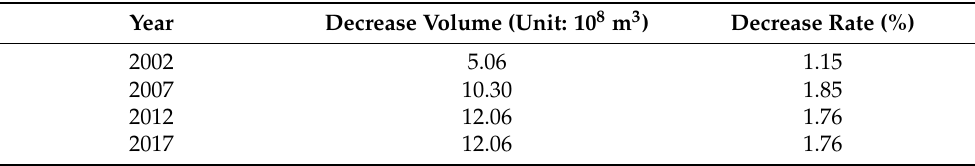
Table 3. Wastewater reduction effects to the entire economic system by reducing 10% final demand on sampled